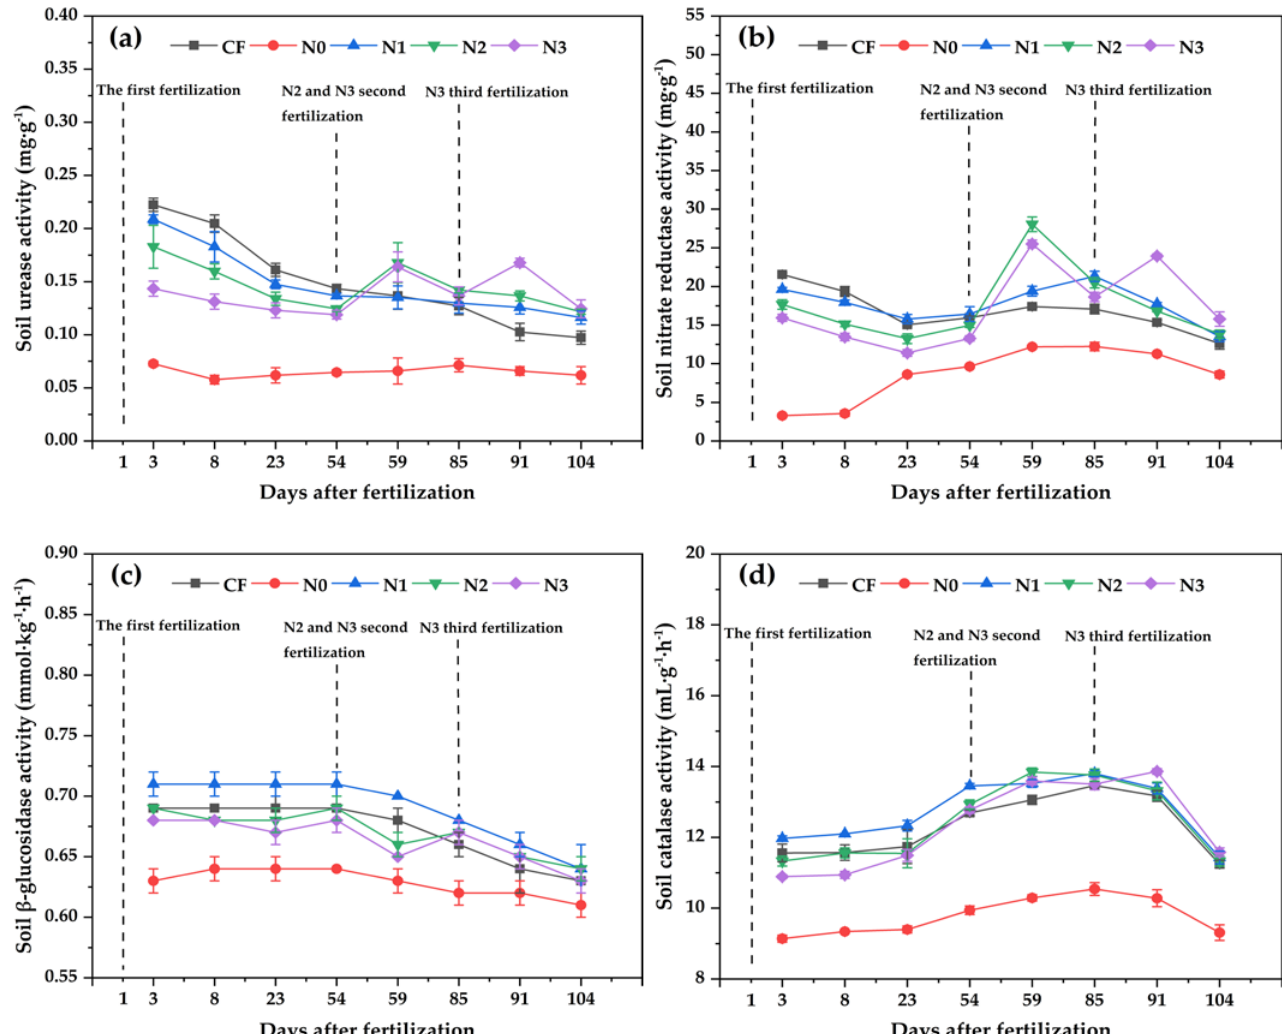
Figure 9. Changes of soil ( a ) urease, ( b ) nitrate, ( c ) β -glucosidase and ( d ) catalase activity in different growth stages of wheat.